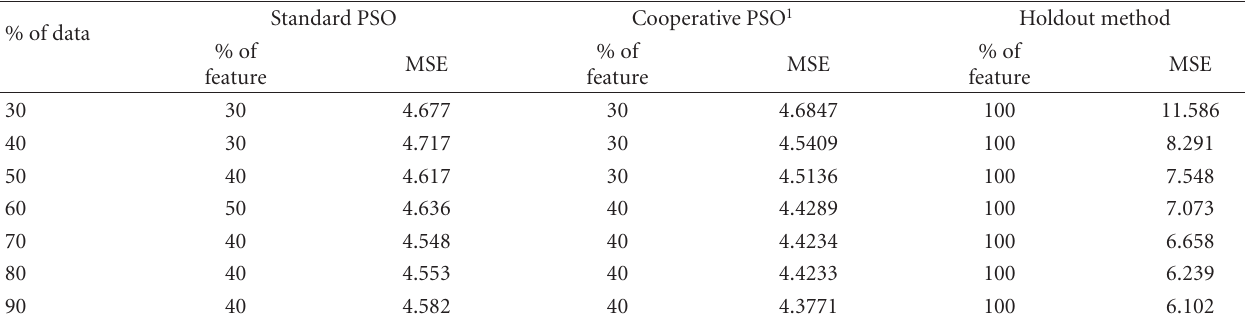
Table 14: The comparison of RMSE obtained when using standard PSO, CPSO, and standard fuzzy model with holdout method for body fat data with C = 3.